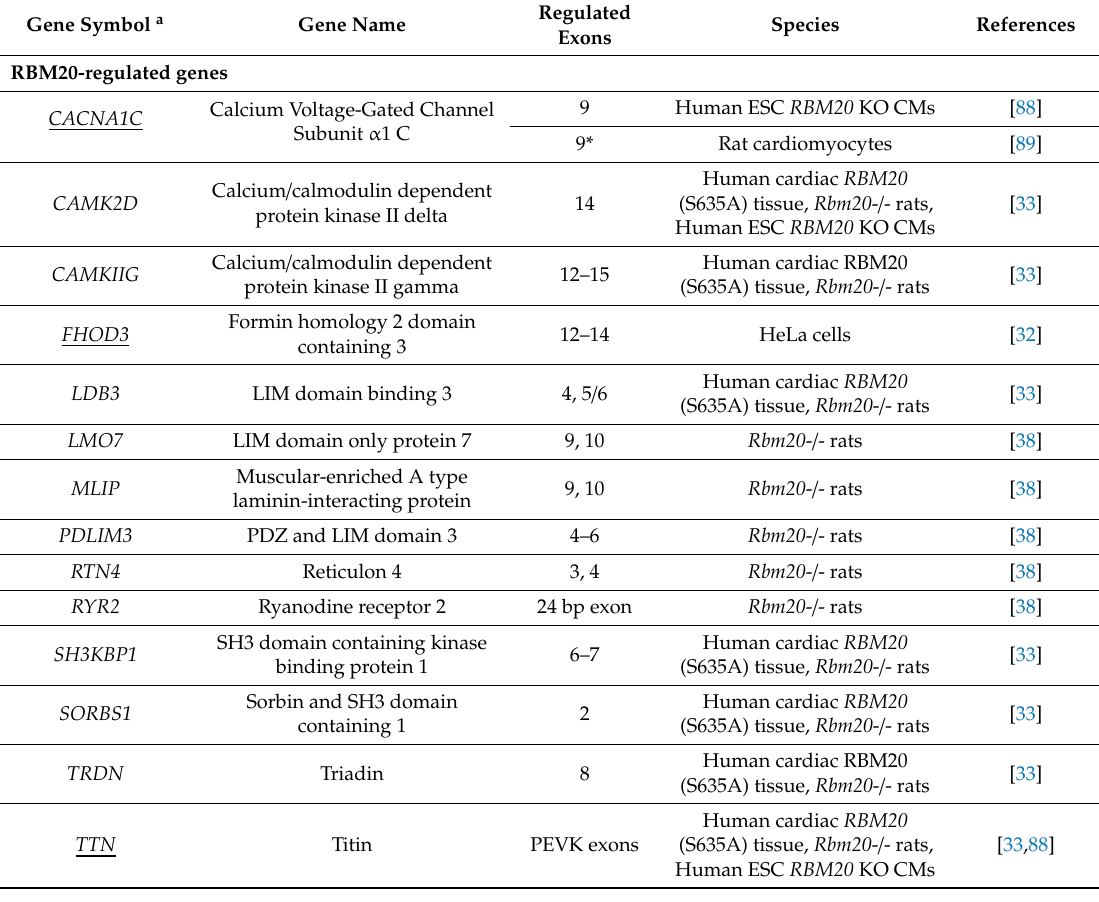
Table 1. Representative heart genes regulated by RBM20 and